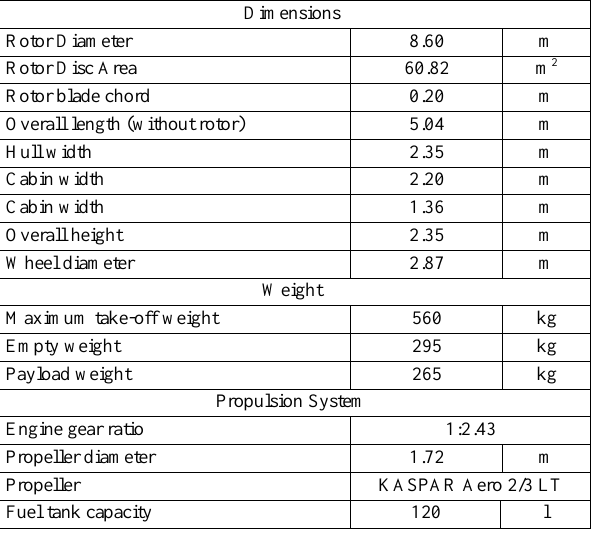
Table. 1 Technical data of Tercel autogyro [26]